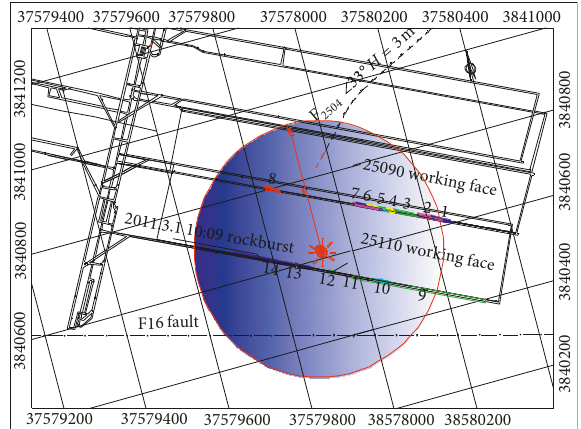
Figure 8: “3.1” rock burst dynamic system of the 25110 working interface of Yuejin